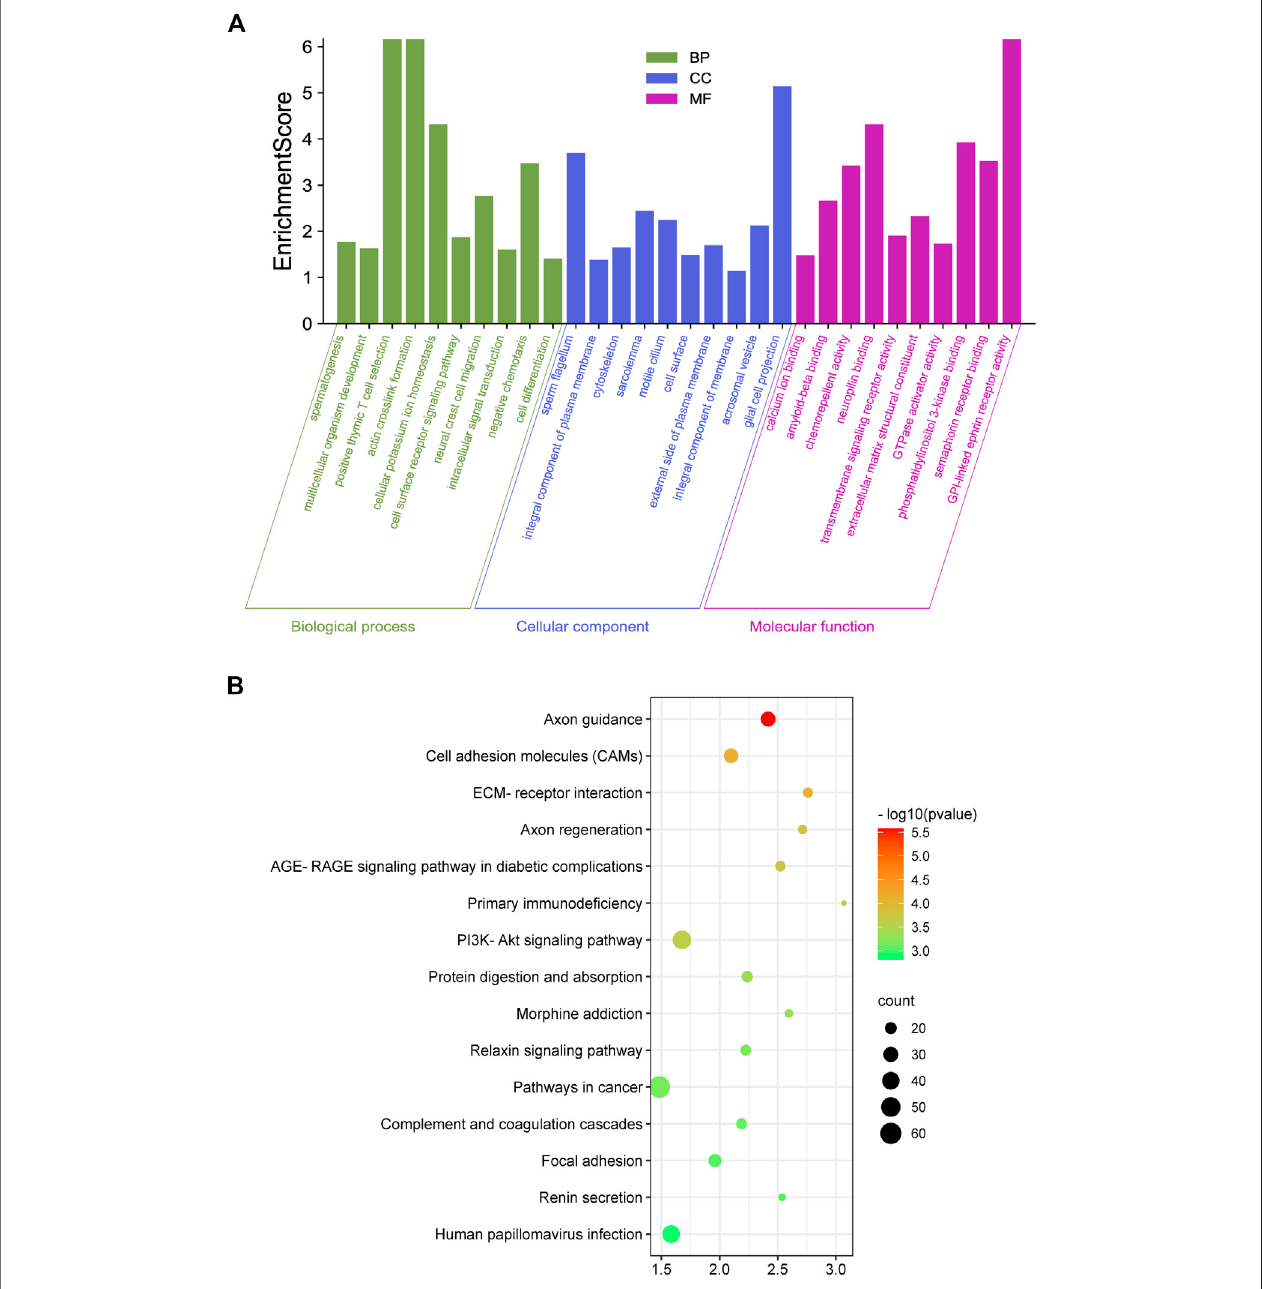
FIGURE 5 | Enrichment analysis. (A,B) , GO (A) and KEGG (B) enrichment analysis of genes differentially expressed before and after sexual maturation.